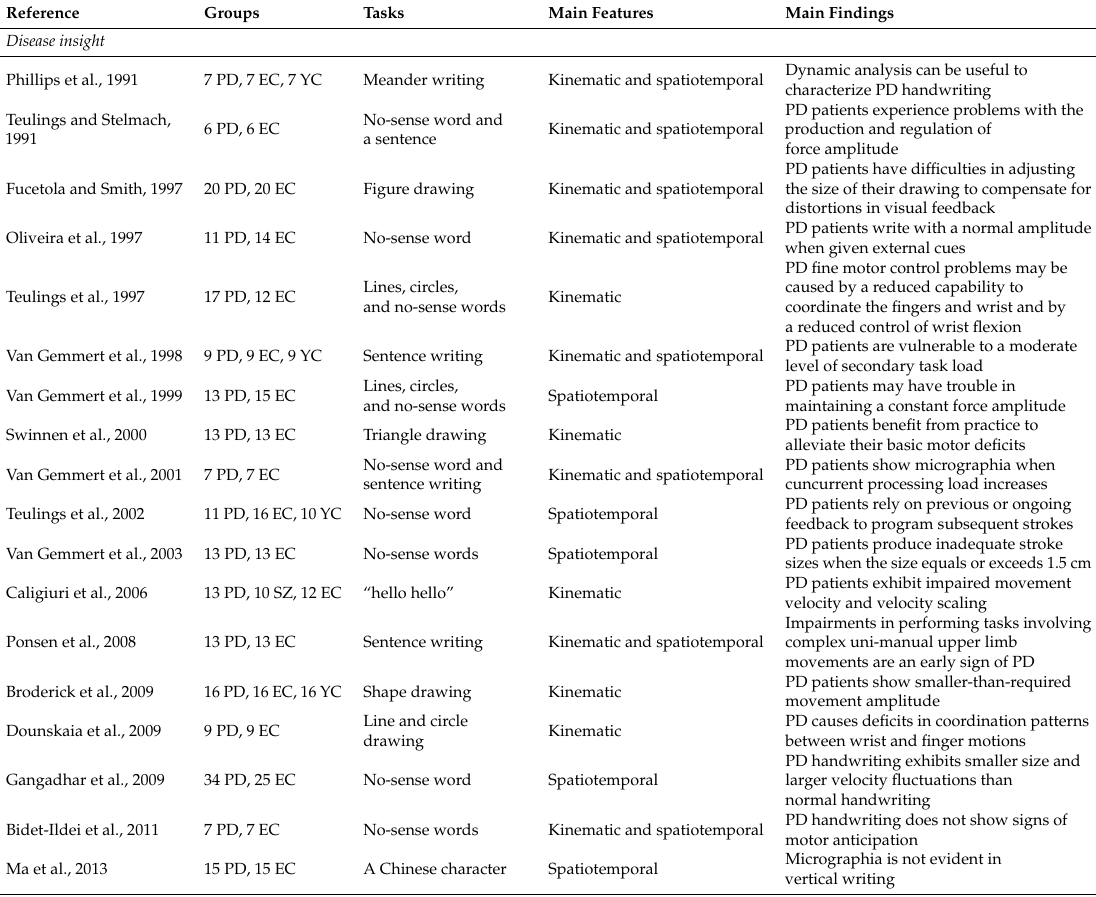
Table 3. Summary of studies on PD (EC = elderly controls; YC = young controls; and SZ = schizophrenia patients).